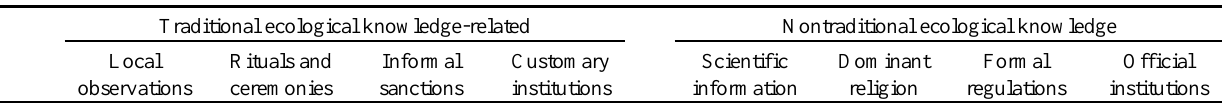
Table 2 . Decision-making mechanisms contributing to sustainable natural resource management and conservation, by type of community-based conservation governance